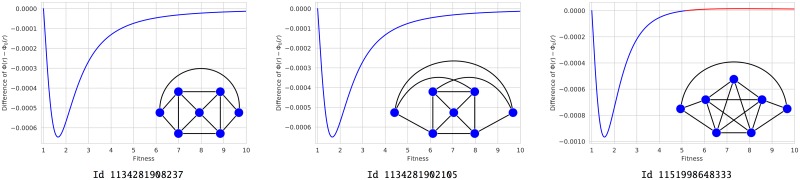
Suppressors for weak selection and beyond.From the symbolic computation of the differences Φ(r) − Φ0(r), we know that the graphs Id 1134281908237 and Id 1134281902105 are suppressors for any fitness value, while Id 1151998648333 exhibit a unique transition Suppressor/Amplifier at rc ≈ 5.17.